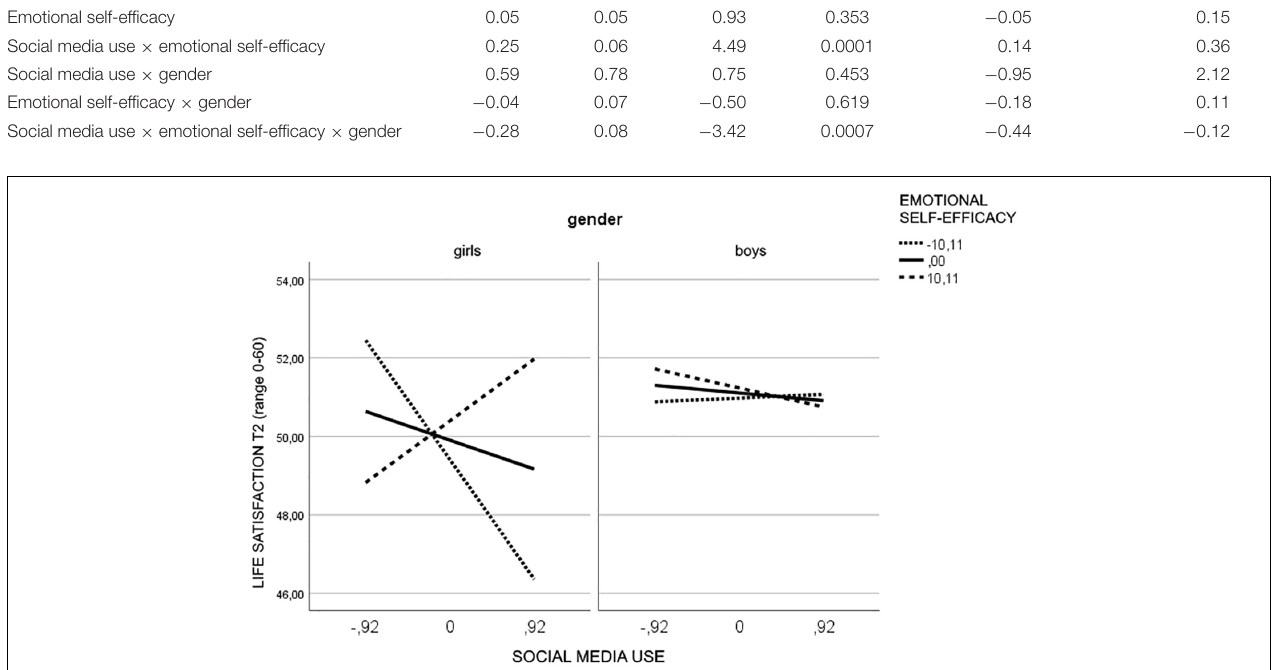
FIGURE 4 | Moderating effect of emotional self-efficacy and gender in the relationship between social media use and life